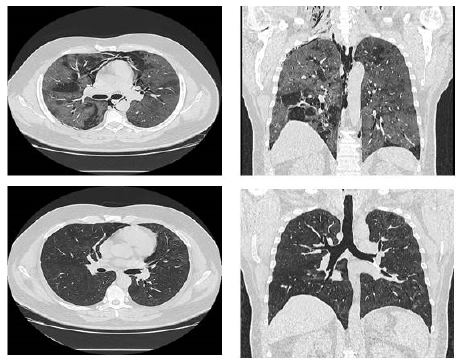
Figure 1. Thoracic CT showing pneumomediastinum and CT, three-months later, showing complete remission of pneumomediastinum.